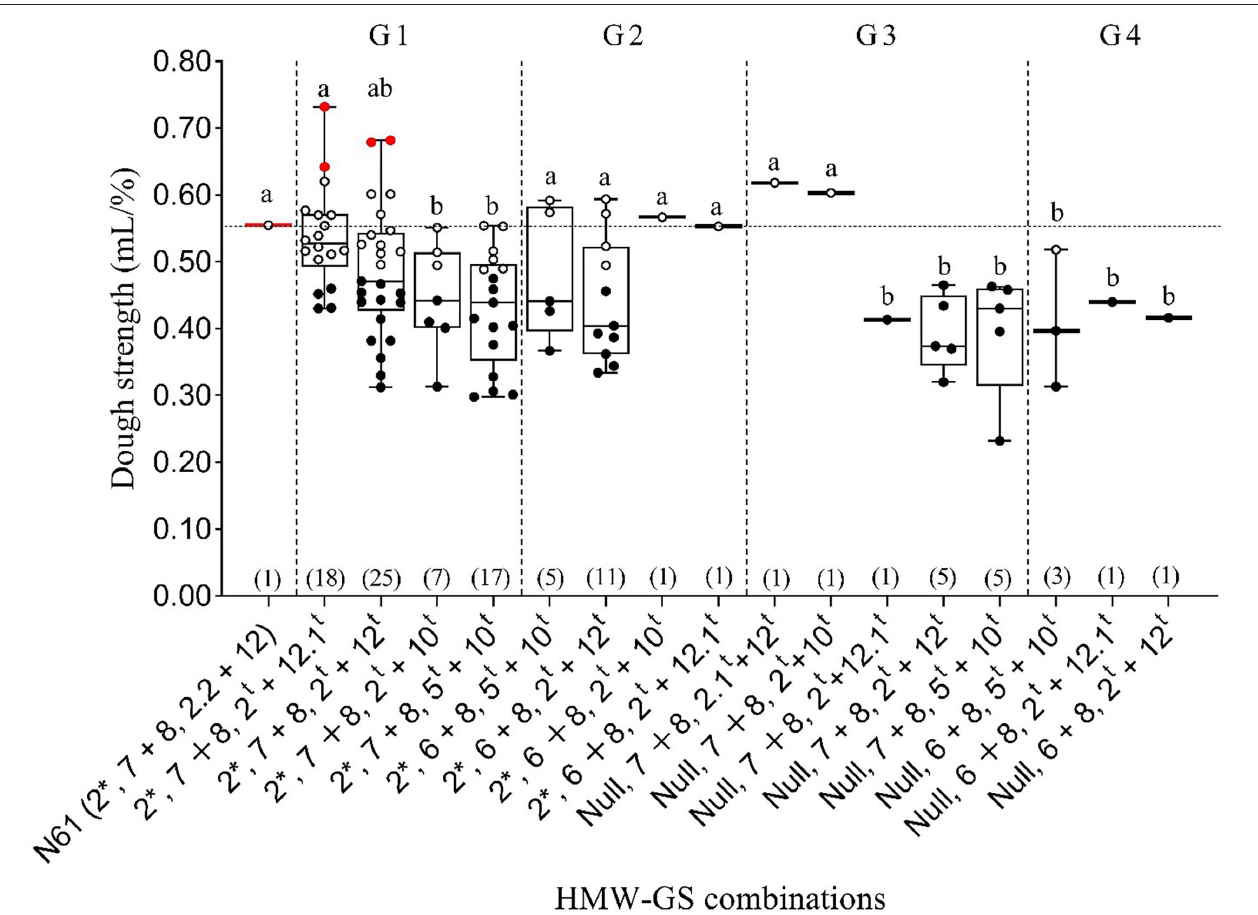
FIGURE 5 | Boxplot of dough strength (mL/%) for different subunit combinations at three Glu-1 loci in 103 MSD lines that derived their HMW-GS from Ae. tauschii and the recurrent parent N61. The horizontal dotted line compares the N61 value with those of MSD lines carrying different subunit combinations, which are separated by dashed vertical lines into groups G1–G4. Within a group, the same letter indicates that the means are not significantly different at the 5% probability level according to Duncan’s Multiple Range Test. Red, white and black dots indicate the MSD lines that had significantly higher, comparable, or lower dough strength, respectively, than N61, according to least significant difference (0.05). Numbers in parentheses refer to the number of MSD lines having each HMW-GS combination.